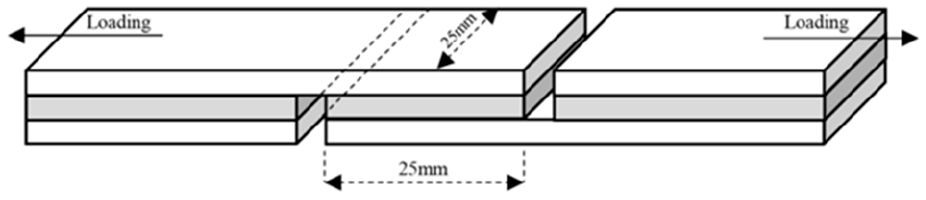
Figure 2. The schematic diagram of the sample preparation and the force loading.